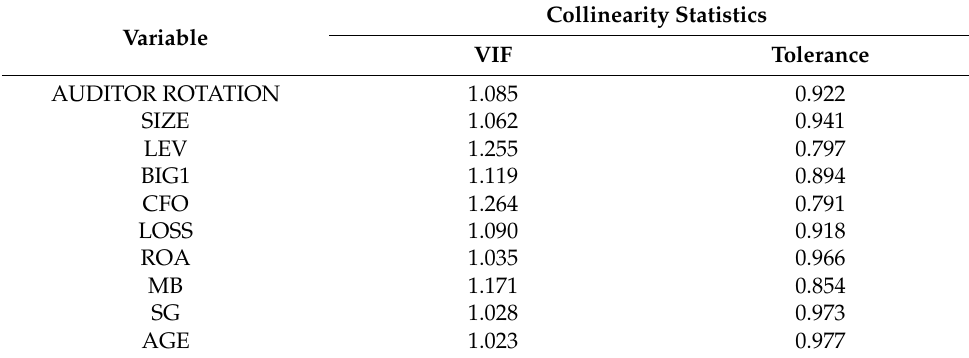
Table 3. Collinearity diagnostics